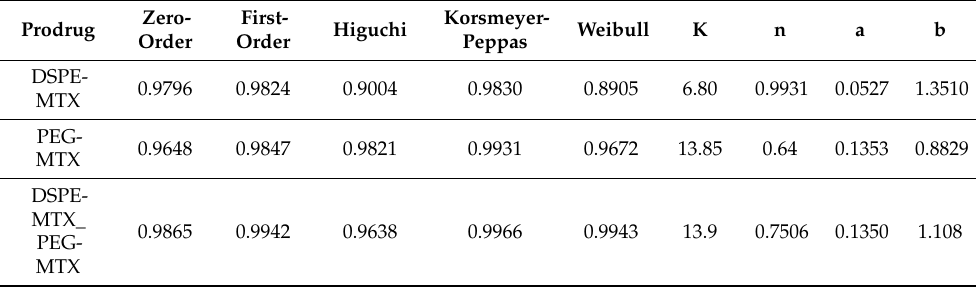
Figure 4. In vitro release profile of DSPE-MTX (red line), PEG-MTX (light green line) and their combinations (purple line) Figure 3. Different experiments ± standard deviation (SD). Table 3. R2 values of the zero-order, first-order kinetic, Higuchi models, Korsmeyer–Peppas and Weibull models. Kinetic parameters for the Korsmeyer–Peppas model: K represents the release rate constant; n represents the release mechanism of drug. Kinetic parameters for the Weibull model: a represents a constant based on the system, and b a constant based on the release